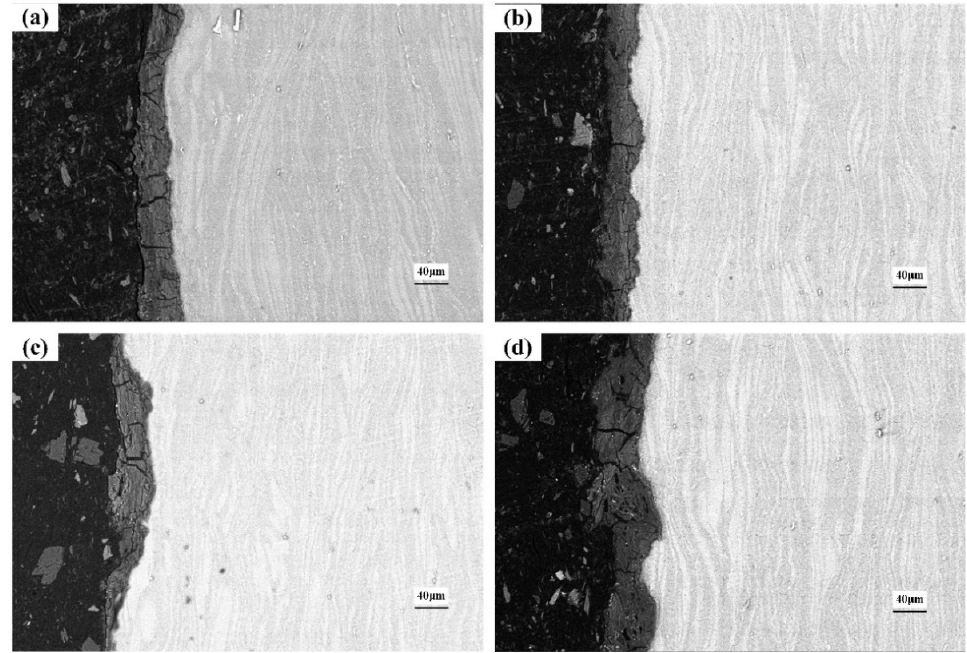
Figure 13. Cross-section morphology after corrosion in 0.6 mol/L Cl − solution: ( a ) 4 h; ( b ) 8 h; ( c ) 18 h; ( d ) 36 h.